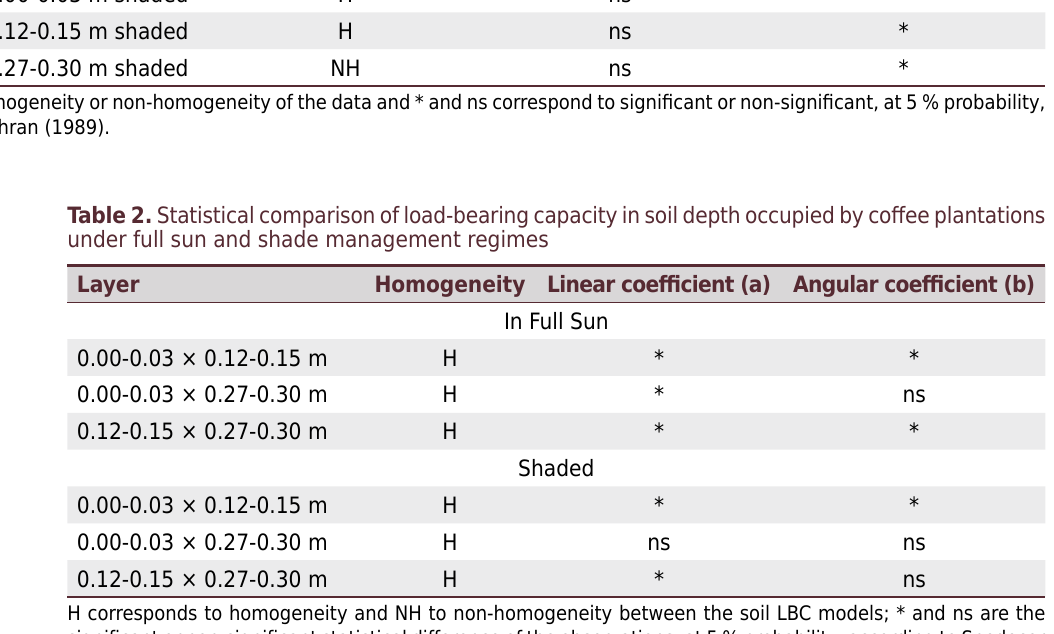
Table 1. Statistical comparison between soil load-bearing capacity models for full sun and shaded treatments Layer